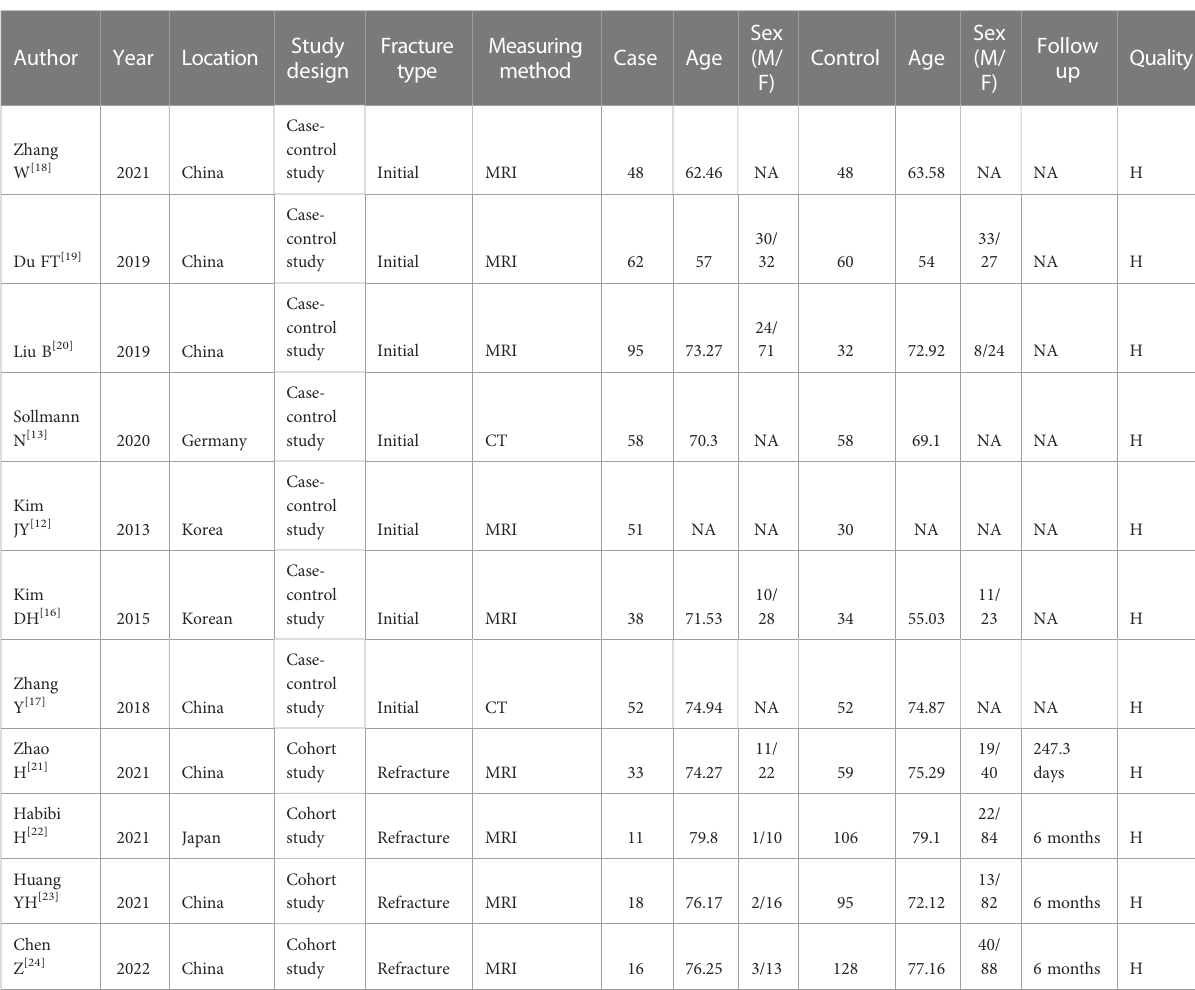
TABLE 1 The characteristics of included studies in this